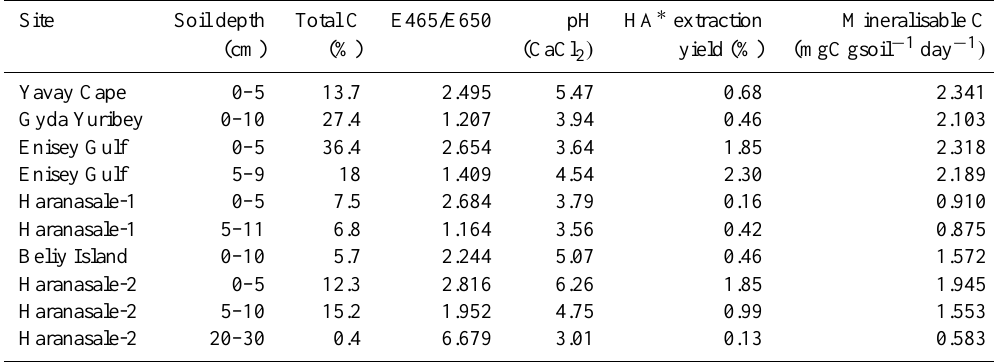
Table 1. Properties of bulk soil organic matter. ∗ Humic acids.